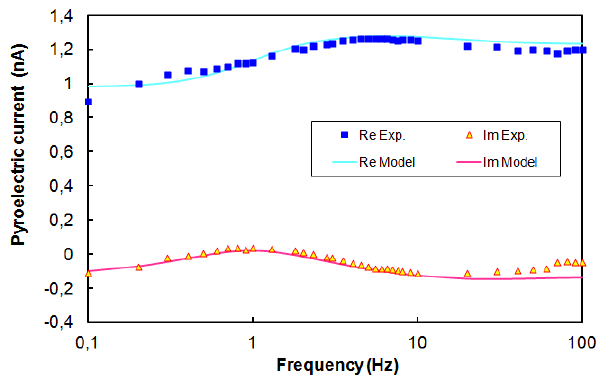
Figure 2. Pyroelectric current spectrum of a LTCC/PZT sensor– actuator in comparison to a fit to Eq. (4) with p 1 = − p 0 /